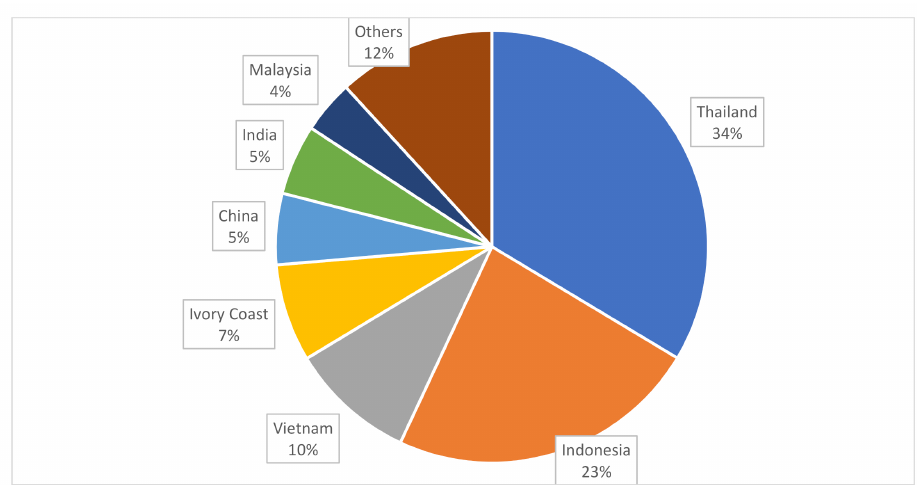
Figure 2. Natural rubber producing countries worldwide in 2020 (Statista